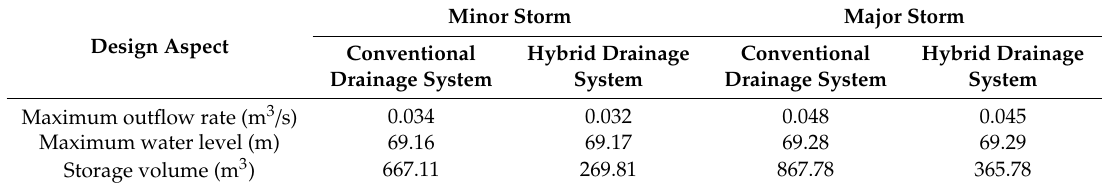
Table 1. Comparison of design output of detention basin for the two drainage